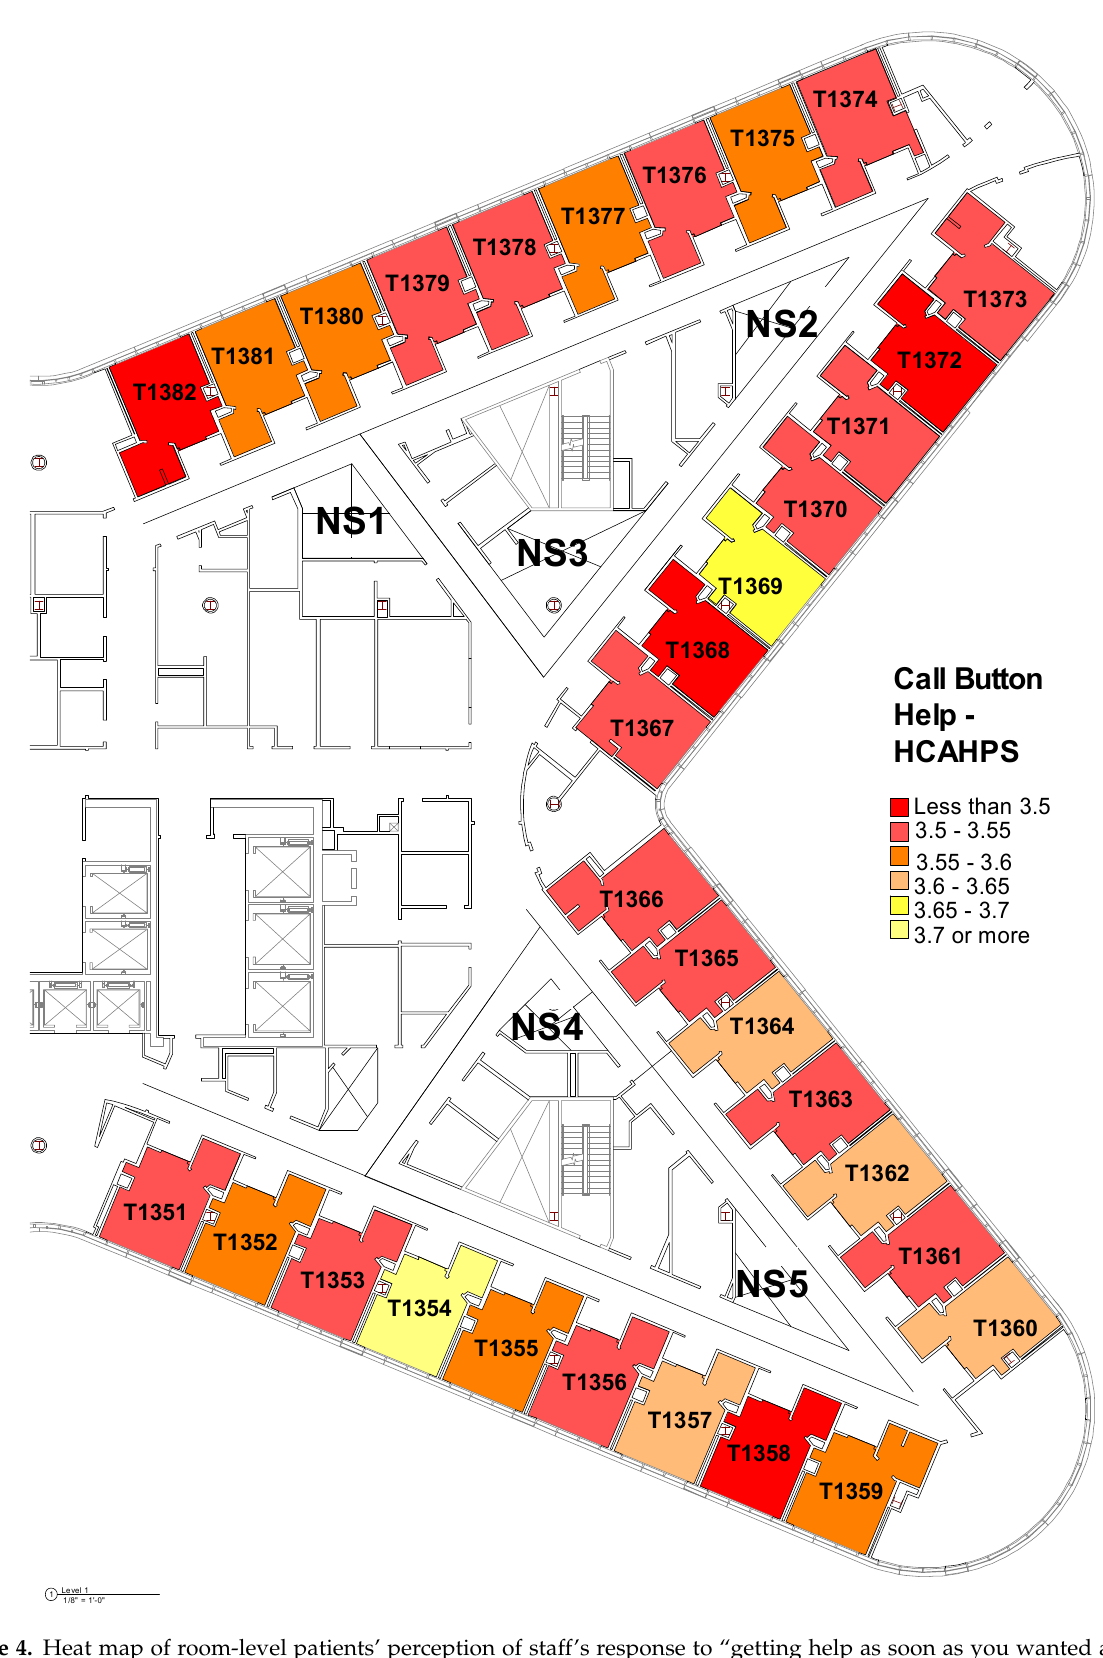
Figure 4. Heat map of room-level patients’ perception of staff’s response to “getting help as soon as you wanted after pressed call button” based on HCAHPS survey.